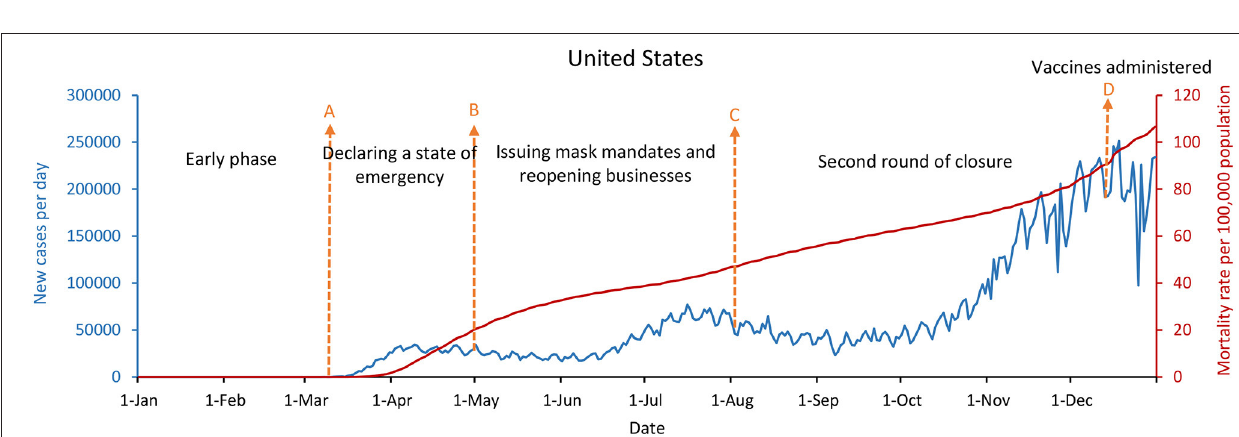
FIGURE 4 | The United States’ COVID-19 epidemic curves and population mortality rate (between January 1 and December 31, 2020). (A) By March 13, 2020, the federal government escalated from public health to a national emergency, and by March 16, all the states had declared a state of emergency or a public health emergency. (B) Starting in May, reopening of businesses and restaurants, and masks mandate for everyone in public spaces. (C) Starting in August, the second round of closure. (D) Starting on December 14, the first doses of the COVID-19 vaccine were